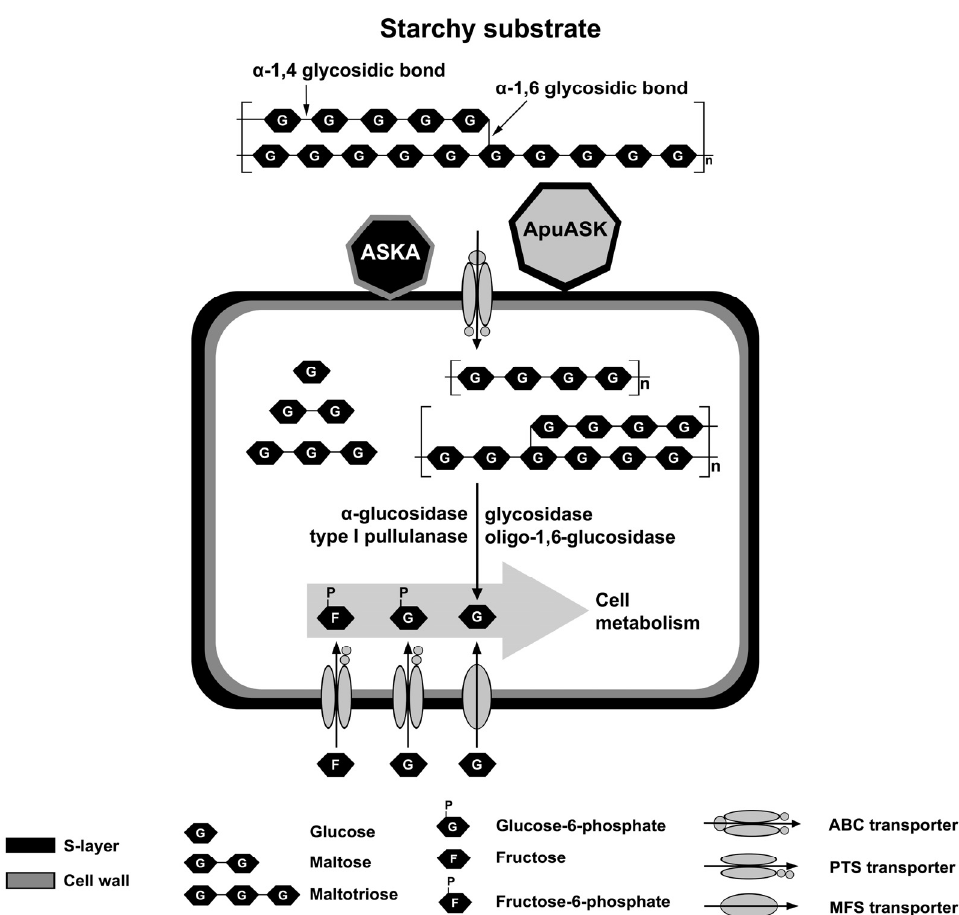
3.0. ApuASK and α -amylase from Anoxybacillus sp. SK3-4, ASKA [33] are